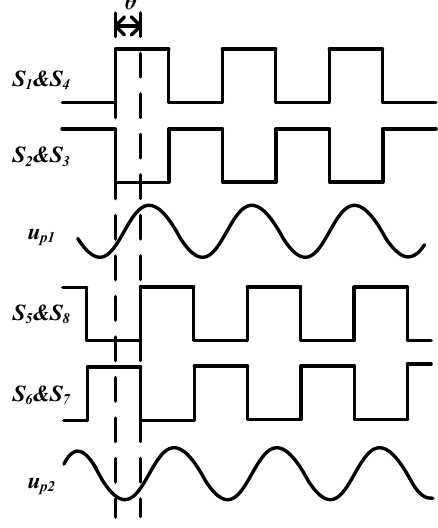
Figure 3. Phase-shifted regulation mode.